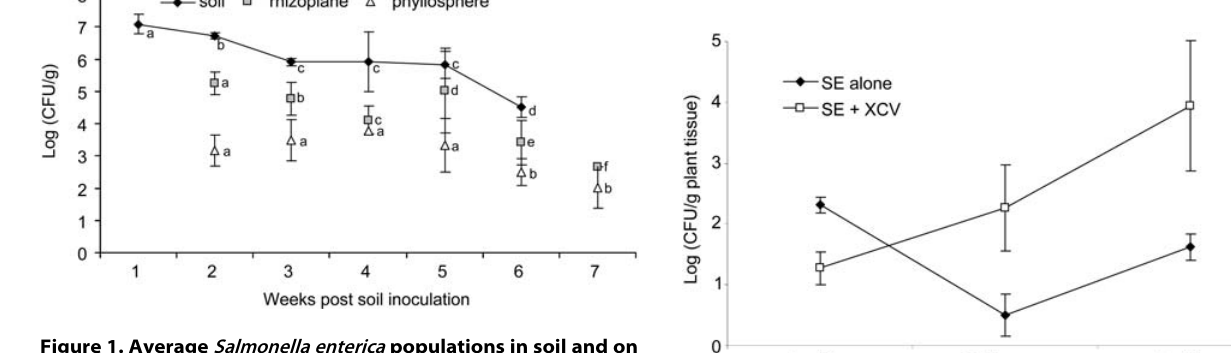
Figure 1. Average Salmonellaenterica populations in soil and on leaves, stems, and roots of tomato. Tomato seeds were sown at weekly intervals in S. enterica irrigated soil and S. enterica populations were enumerated at the seedling stage. Phyllosphere and rhizoplane populations were from seedlings planted one week before sampling. Averages from two experiments were calculated from log transformed data and error bars represent standard deviations. T-tests were preformed to determine average population changes over time for each type of sample. Different letters represent significant population changes (p , 0.03).